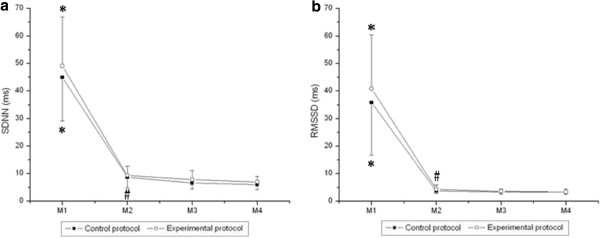
Values are means ± standard deviation. SDNN (a) and RMSSD (b) during exercise and the comparison in control and experimental protocols. Final 5 minutes of rest (M1) and minutes of exercise: 25th to 30th (M2), 55th to 60th (M3), 85th to 90th (M4). *Different from M2, M3 and M4 (p<0.05). #Different from M4 (p<0.05).